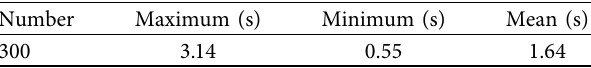
Figure 6: The violin plot of test data in DTSC. Table 2: The statistics of DRT in DTSC.